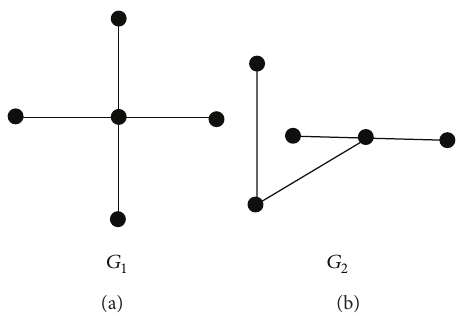
Figure 2: The graphs 𝐺 1 and 𝐺 2